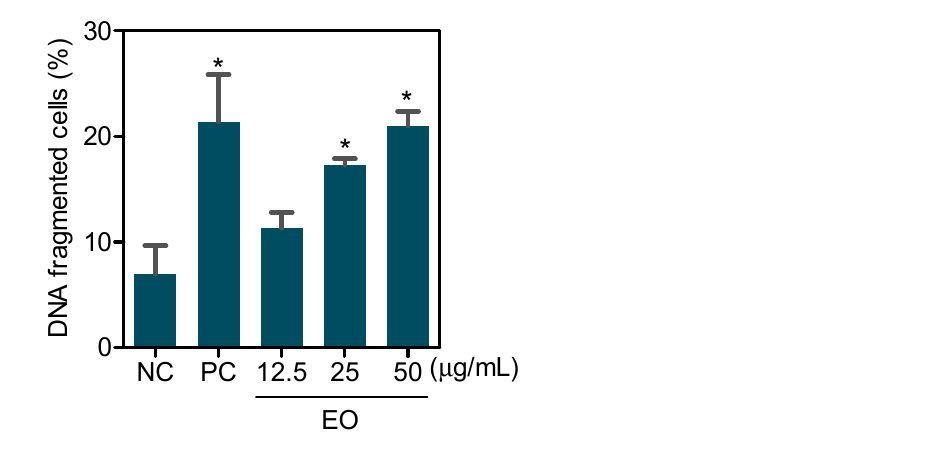
Figure 4. Effect of G. olivacea leaf EO in the DNA fragmentation of HepG2 cells after 48 h of treatment. Negative control ( NC ) was treated with vehicle (0.5% DMSO) used for diluting EO, and doxorubicin (0.5 µ g/mL) was used as positive control ( PC ). Data are presented as mean ± S.E.M. of three independent experiments performed in duplicate. * p < 0.05 compared with negative control by ANOVA, followed by Student–Newman–Keuls test.